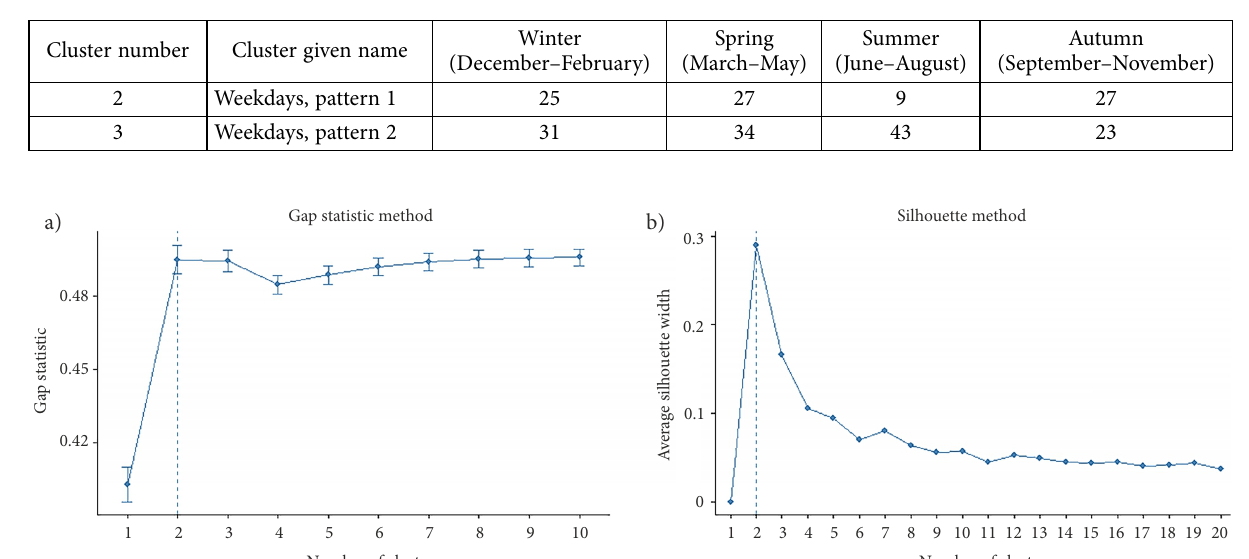
Table 5. Distribution of weekday cluster components over the seasons